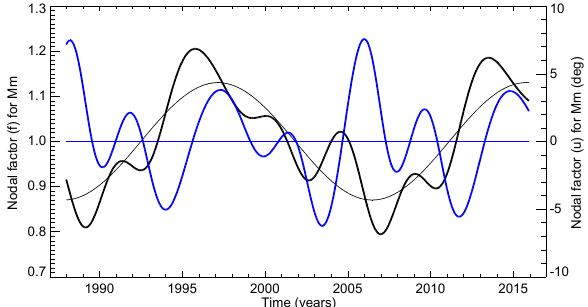
Figure 10. The nodal factors f and u for Mm at 58 ◦ S. The two ap- proximately equal nodal sidebands result in the f and u in Eq. (8) (or Eq. A8), as indicated by the thin black and blue lines, respec- tively, with values shown on the left and right axes, respectively. The overall values of f and u for Mm, after taking into account the sidebands included in Eq. (A9), are shown by the thick black and blue lines,